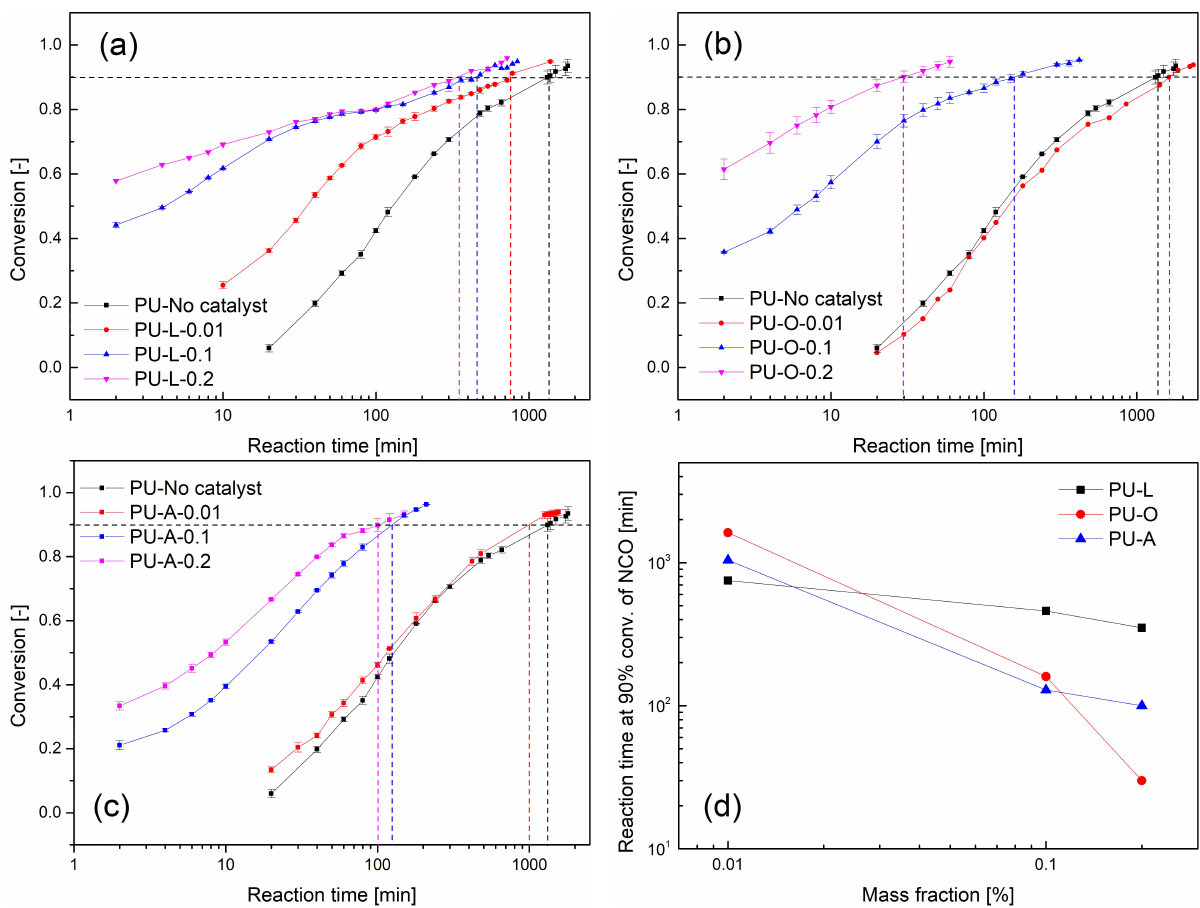
Figure 8: Conversion of NCO group for polyurethane with different reactive additives calculated from the FTIR spectrum (a-c). Reaction times to reach 90% conversion as a function of catalyst concentration